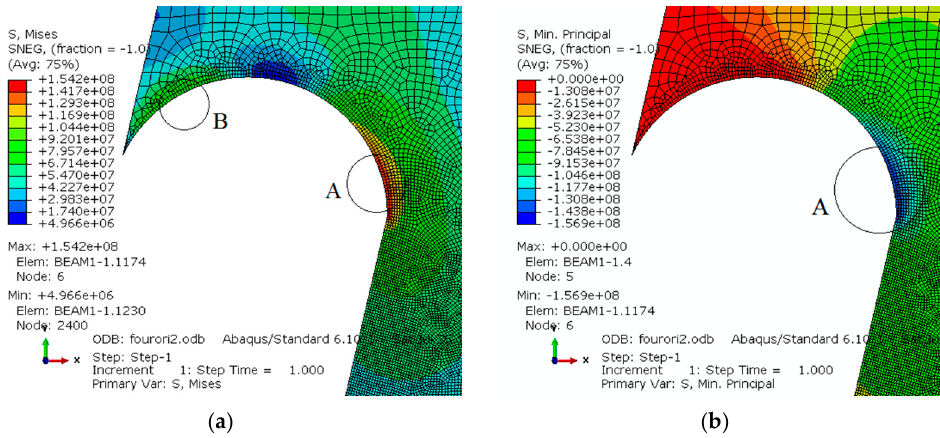
Figure 7. Stress around the diaphragm cutout: ( a ) Mises equivalent stress (Pa), ( b ) principal compressive stress (Pa).